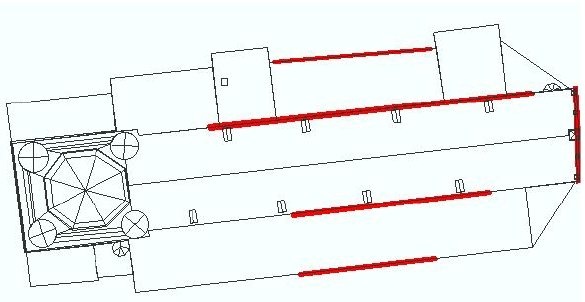
Figure 6. Location of the test areas (red) for determination of differences between the UAS DSM and TLS DSM